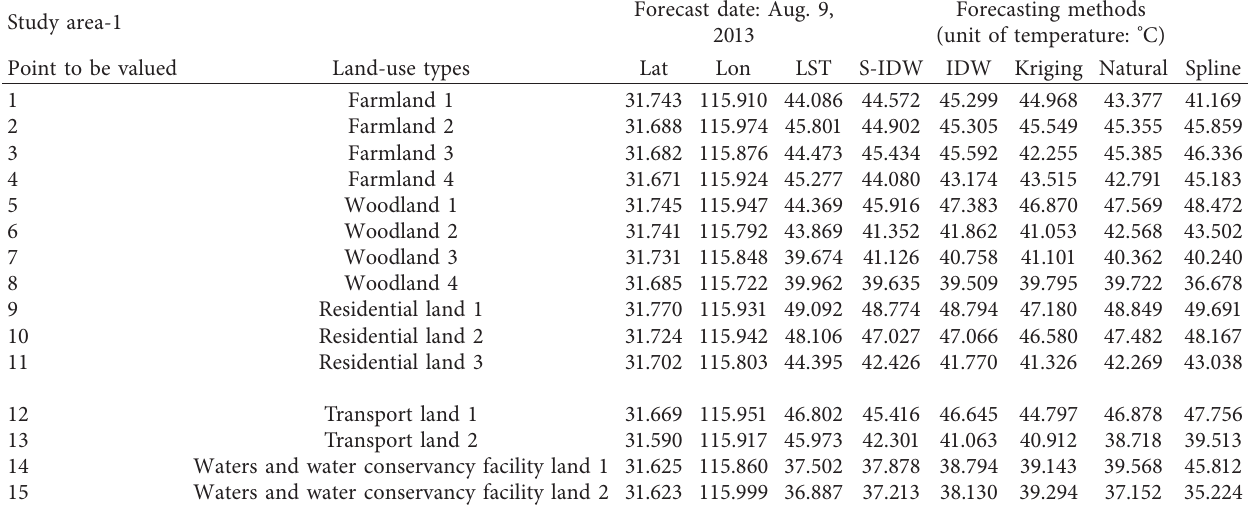
Table 9: Comparison of interpolation results of 5 kinds of interpolation methods on Aug. 9, 2013. Study area-1